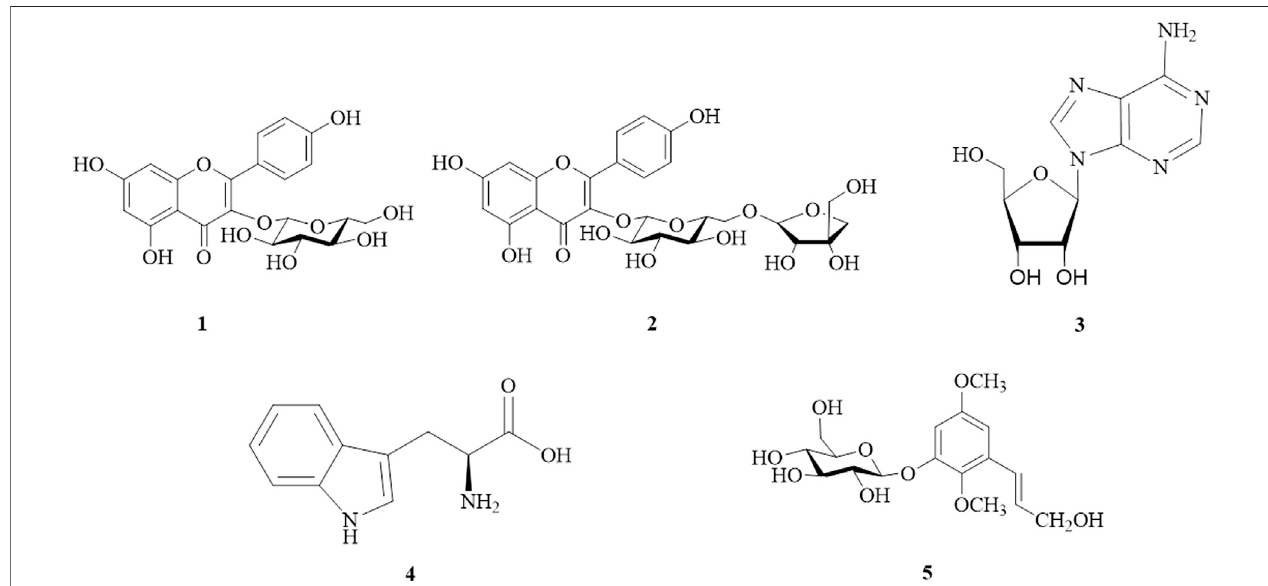
FIGURE 2 | Structures of isolated compounds from Wikstroemia taiwanensis. 1 , astragalin; 2 , kaempferol 3- O - β - D -apiofuranosyl-(1 → 6)- β - D -glucopyranoside; 3 , adenosine; 4 , tryptophan; and 5 , 2,5-dimethoxy-3- O - β - D -glucopyranosyl cinnamic alcohol.